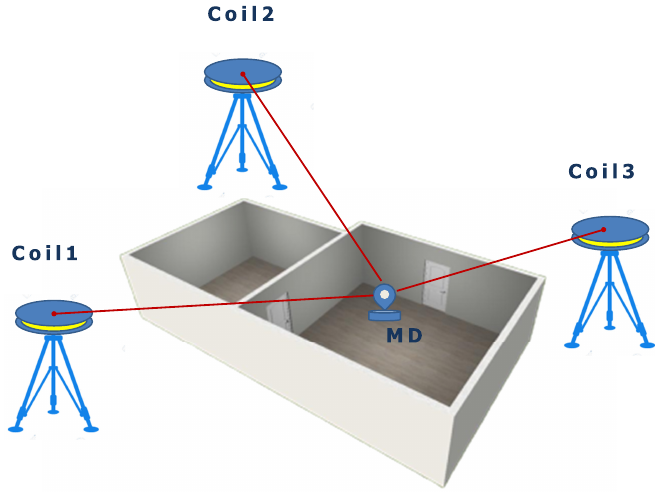
Figure 3. Magnetic-based indoor localization system. MD, Mobile